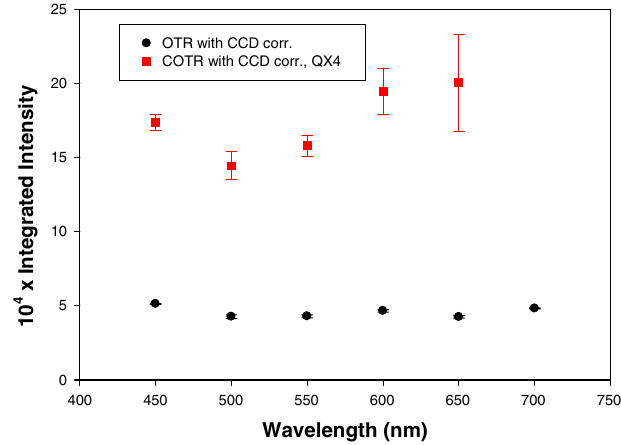
FIG. 10. (Color) Evaluation of the OTR and COTR image intensities versus the bandpass filter center wavelength for the compressed PC rf gun beam (red squares) and compressed TC rf gun beam (black circles) with charge normalized. The COTR has a relatively stronger red component than the incoherent OTR.